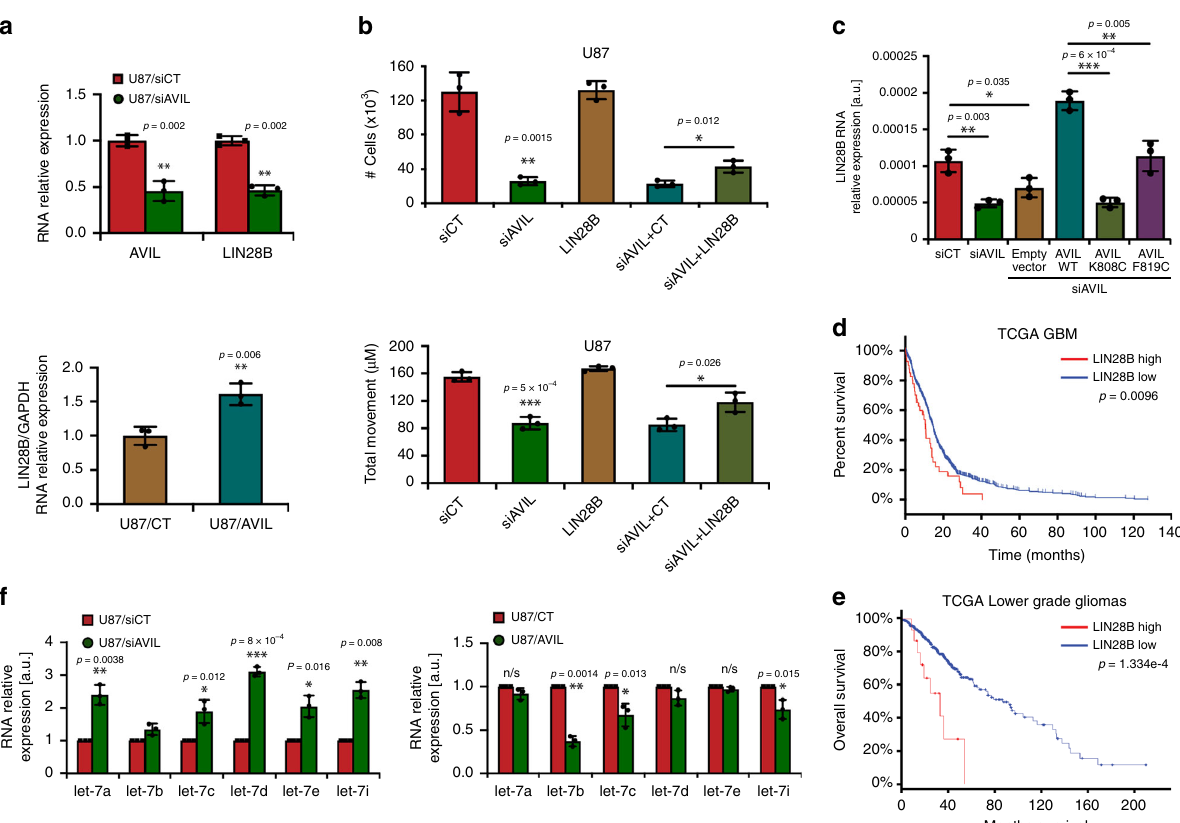
Fig. 8 AVIL regulates LIN28B expression through FOXM1. a LIN28B was reduced upon AVIL silencing, and induced upon AVIL overexpression. U87 cells were transfected with siAVIL or siCT, and empty vector control (CT) or AVIL expressing vector. LIN28B level was measured by qRT-PCR, and normalized to that of GAPDH , and then to siCT. b LIN28B mediates at least some of the AVIL effect. U87 cells transfected with siAVIL or siCT were further transfected with LIN28B expression vector, or control plasmid (CT). Cell proliferation was measured by cell counting. Cell motility was measured by wound-healing assay. c Headpiece mutants are not as effective as WT in inducing LIN28B expression. LIN28B expression was measured by qRT-PCR and is represented relative to GAPDH levels. d Clinical correlation between the expression of LIN28B and patient survival. A two-class model, strati fi ed by LIN28B expression using TCGA GBM data. The LIN28B high group has a signi fi cantly worse survival ( p < 0.01, two-sided log-rank test). e With TCGA lower-grade glioma data, LIN28B high group is found to have worse overall survival ( p = 0.00013) (two-sided log-rank test). f Let-7 family members were induced upon AVIL silencing, and suppressed upon AVIL overexpression. Let-7 family members that are expressed in U87 were measured by qRT-PCR. Their expression levels were plotted against that of siCT, or CT. * p < 0.05, ** p < 0.01, *** p < 0.001. Data are presented as mean values ± SD in a – c , and f